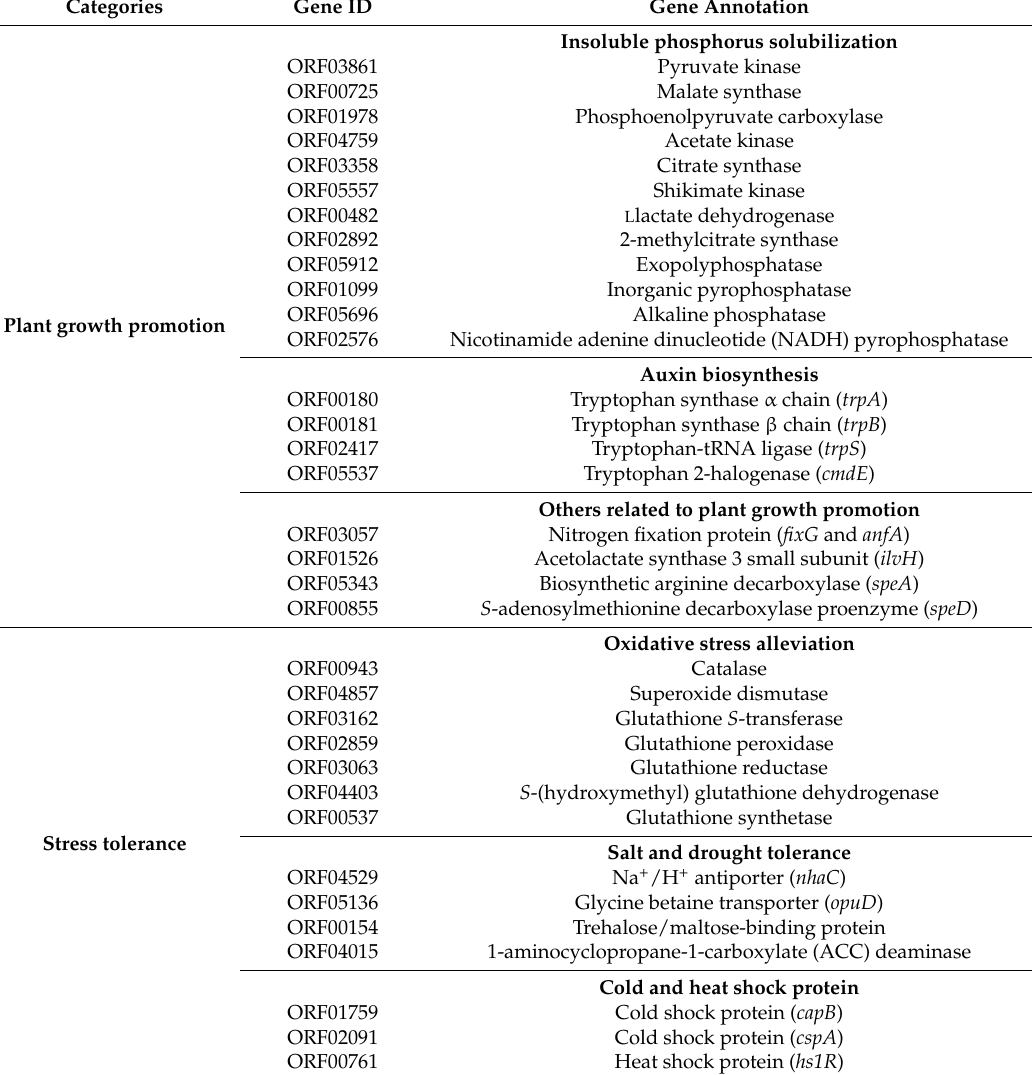
Table 2. Potential genes responsible for plant growth promotion and stress tolerance in Pseudomonas sp. M30-35